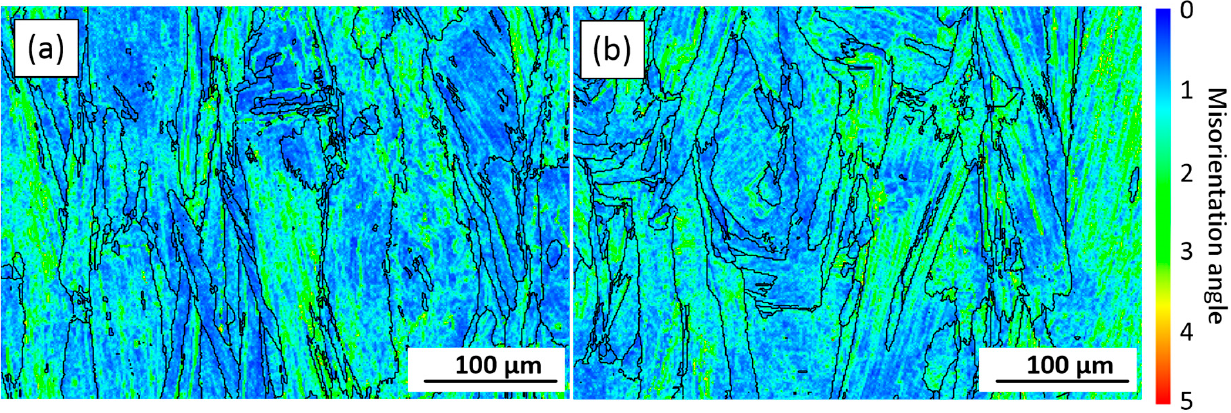
Figure 8. KAM maps (ZX plane) of the analyzed areas in the as-built ( a ) Alloy 1 and ( b ) Alloy 2.